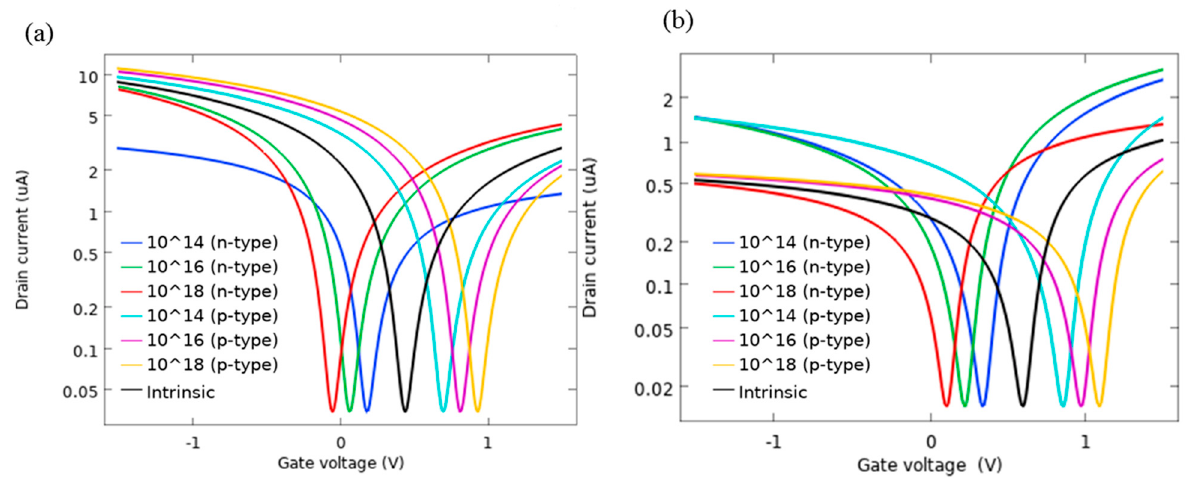
Figure 11. I–V characteristics as a function of doping type and concentration for ( a ) AlP-GFET, ( b ) Pd- GFET.